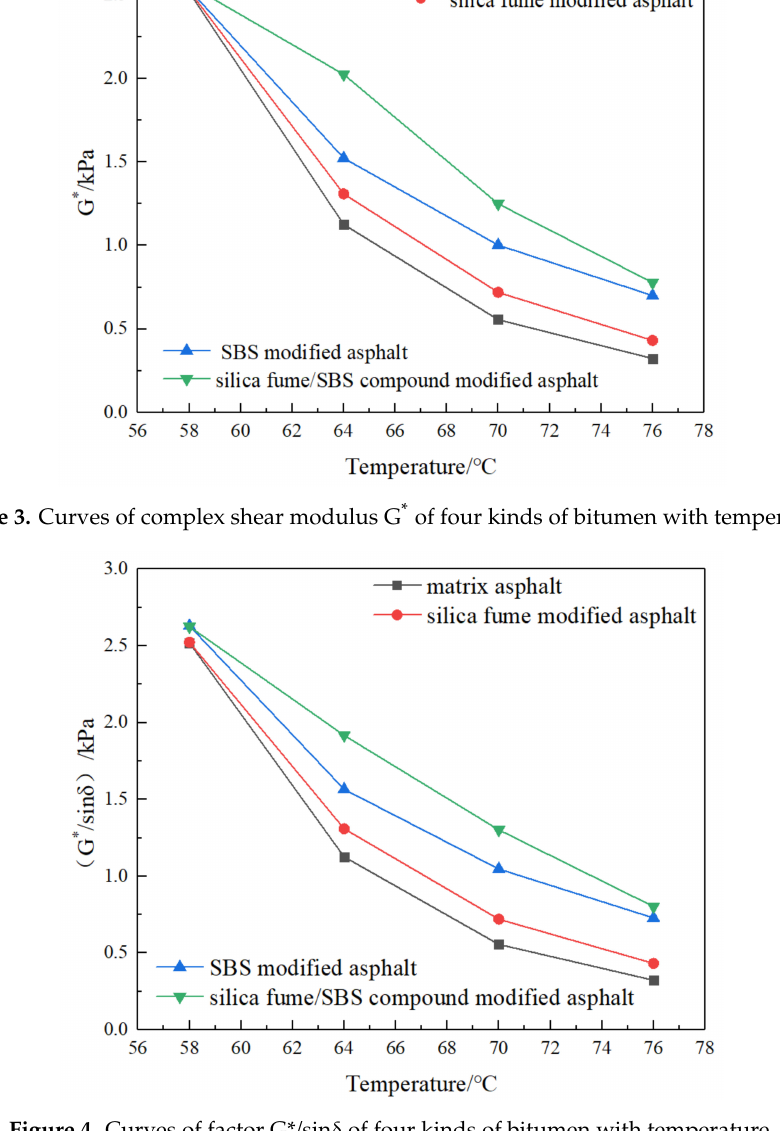
Figure 4. Curves of factor G* / sin δ of four kinds of bitumen with